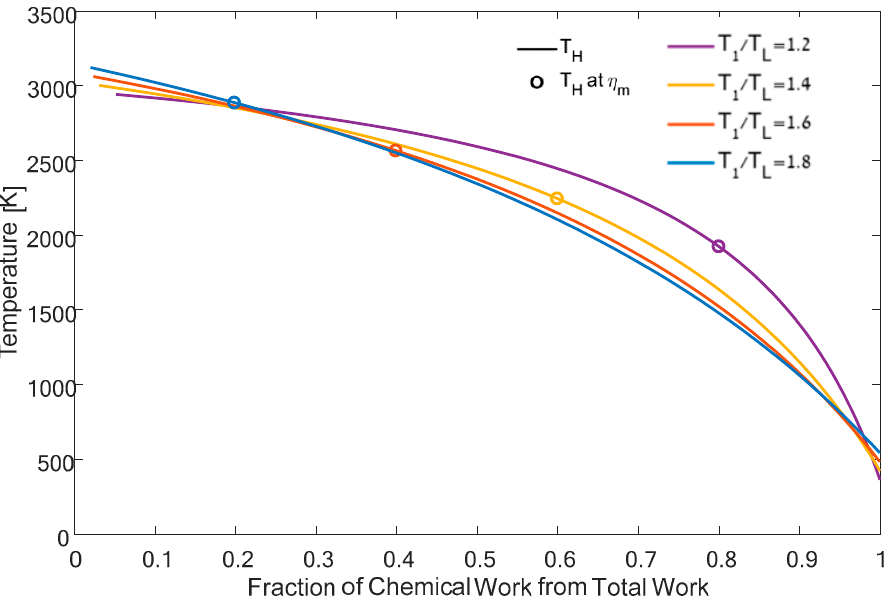
Figure 3. Temperature before expansion in the Otto cycle ( T H ) as a function of the chemical work fraction for di ff erent T 1 / T L ratios. is a mark for T H at maximum power for each T 1 / T L ratios.